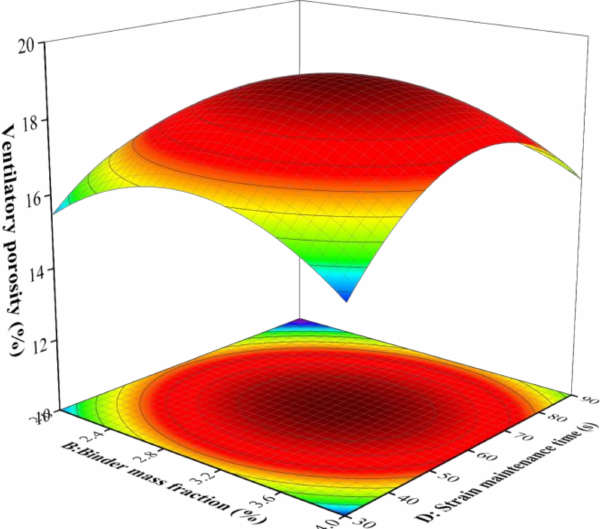
Figure 4. Interaction effect of binder mass fraction and strain maintenance time on ventilatory porosity with the moisture content of 35% and molding compression ratio of